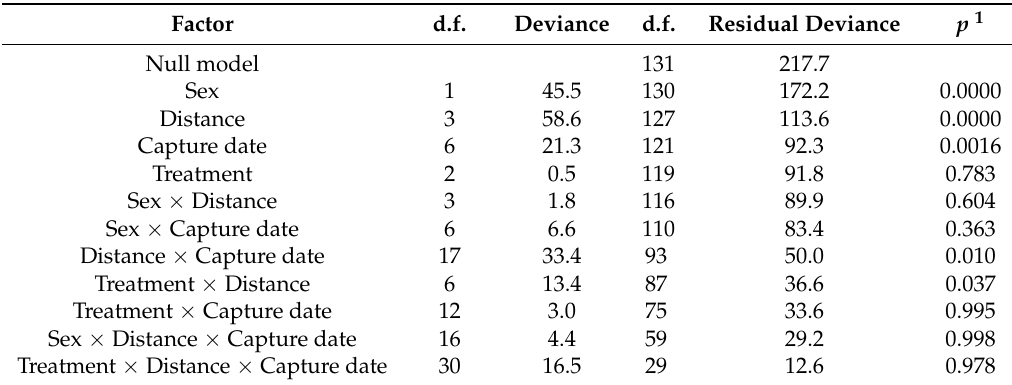
Table 2. Analysis of deviance of Anartia fatima dispersal data from October.